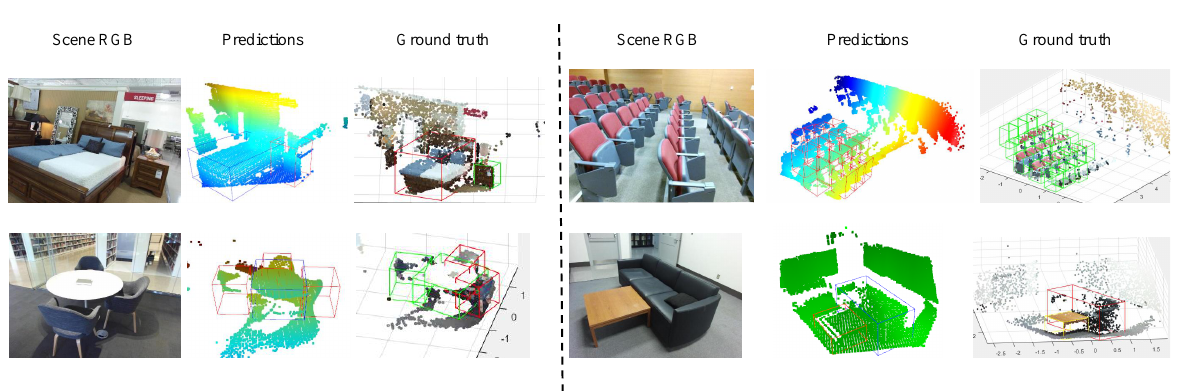
Figure 9. Examples of qualitative detection results on SUN RGB-D dataset. In all set of images from left to right: a RGB image from test set, predicted 3D bounding boxes by our framework and annotated ground-truth the network has difficulty to converge in those